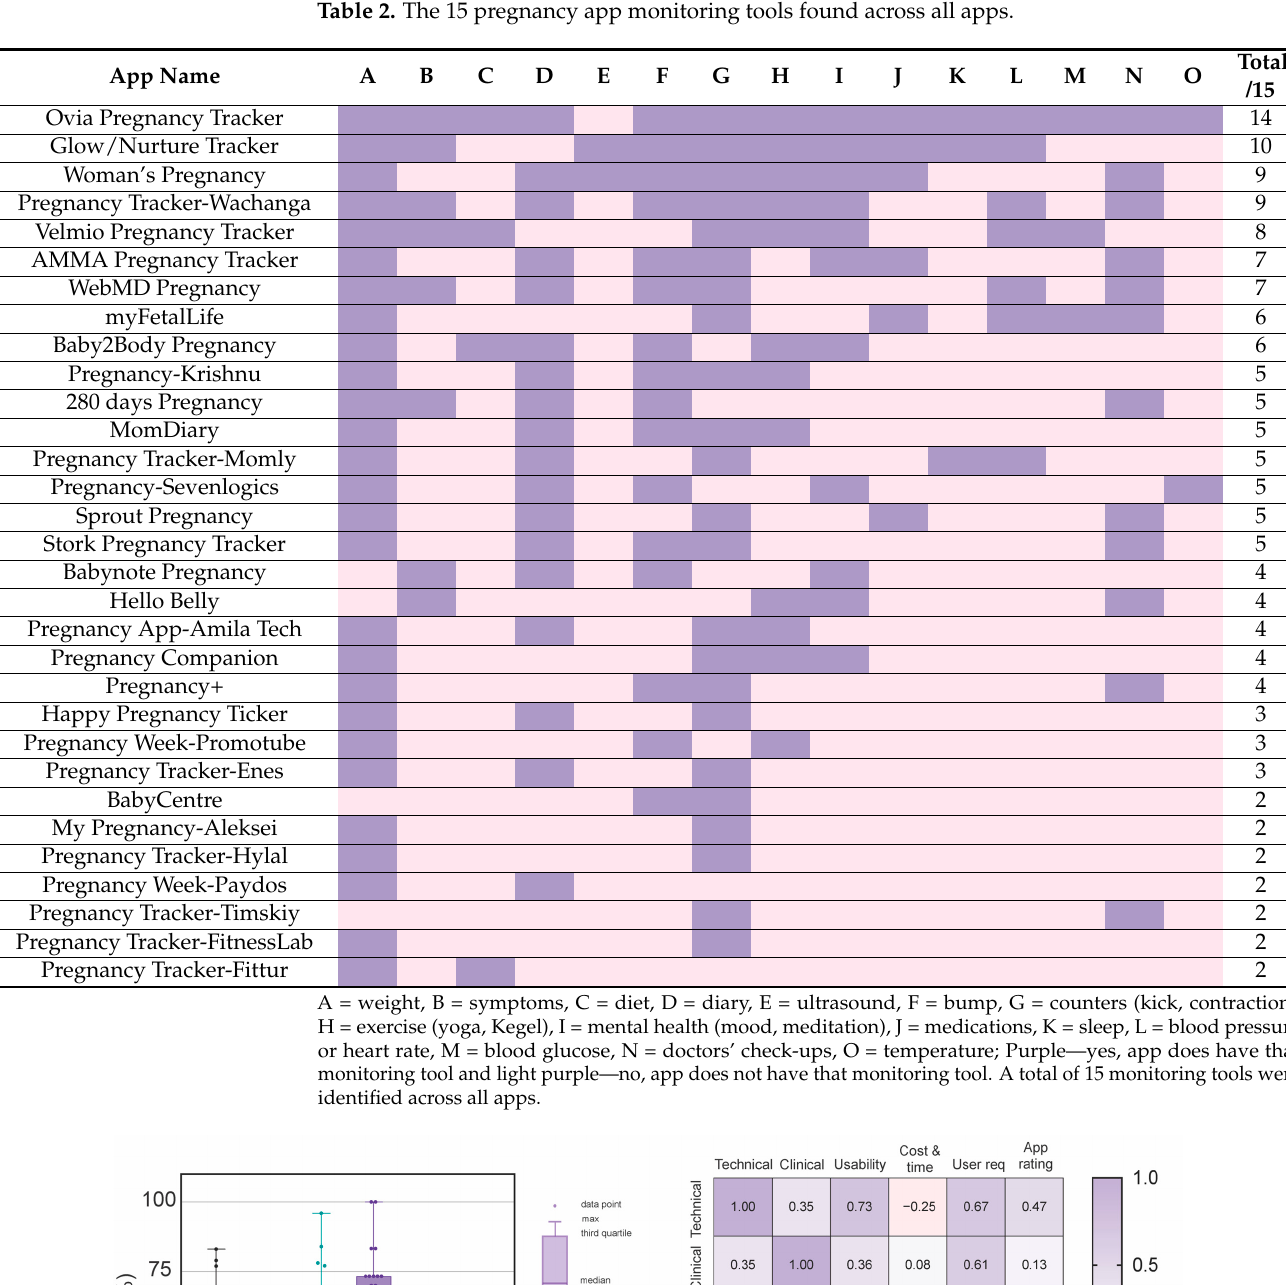
Table 2. The 15 pregnancy app monitoring tools found across all apps.